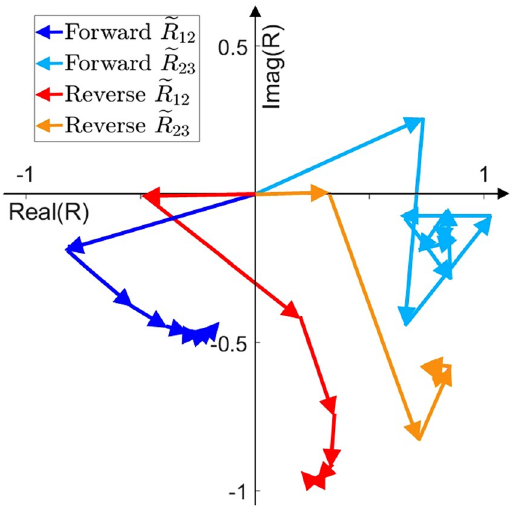
Figure 5. Effective reflection coefficient at air-VO 2 interface (  R of reflection coefficients due to each reflection for TE polarized incident plane wave of wavelength λ th = 8.5 μ m and angle of incidence